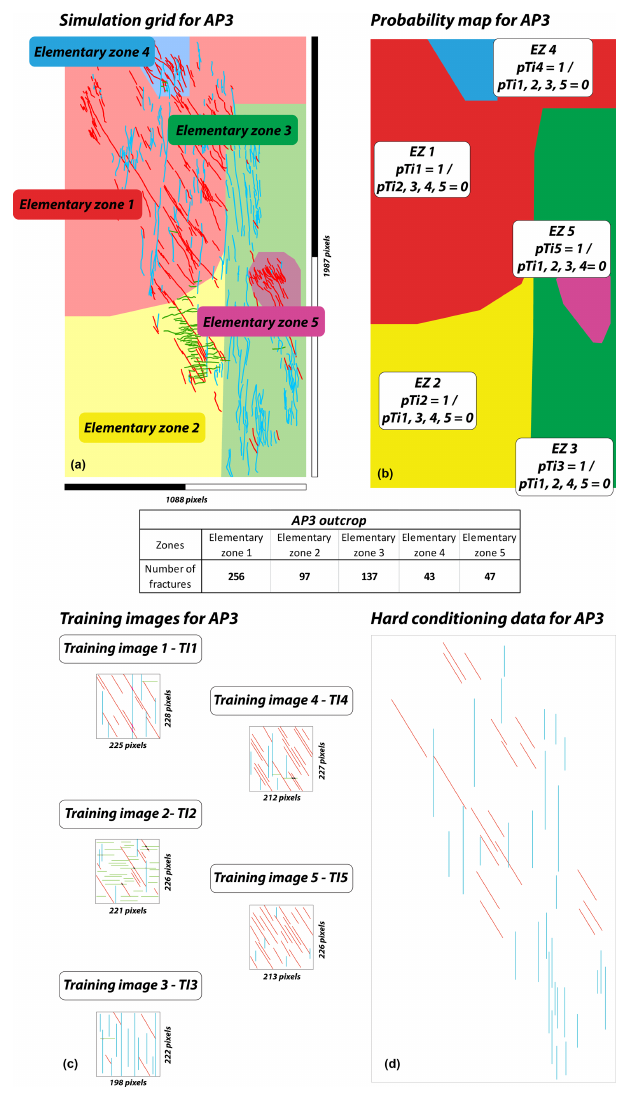
Figure 5. (a) Partitioning of AP3 into five elementary zones (EZ). This partition is defined with respect to fracture orientation (which in this case defines the fracture facies), fracture density and geom- etry variability over the entire simulation domain. (b) Probability map and associated statistics for each EZ. (c) Training images as- sociated with the partition of AP3. In each EZ, the corresponding training image has a probability (pTI) of one of being used. In this zone the other training images are not used (pTI = 0). (d) Hard con- ditioning data for AP3. All of the fractures longer than 40m are considered deterministically in the simulation process.